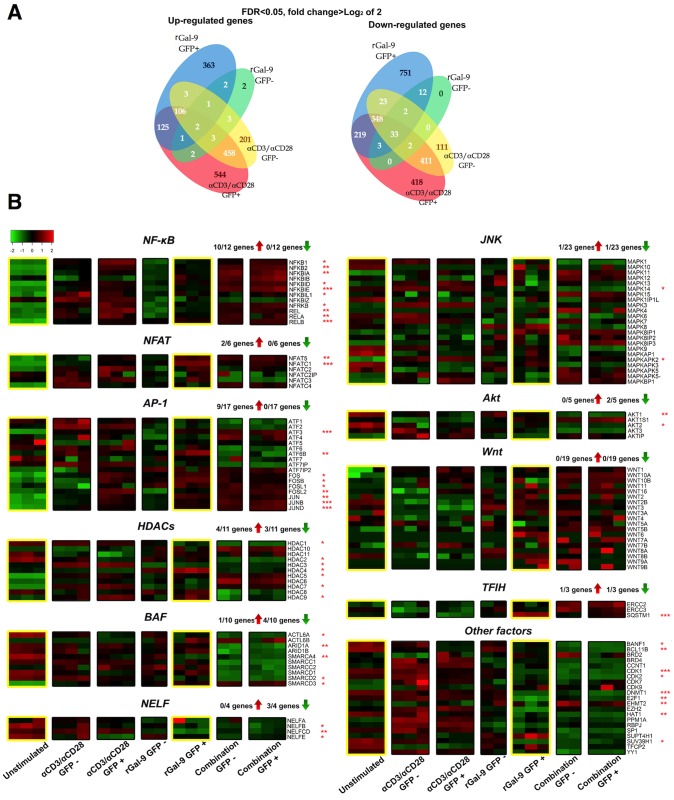
rGal-9 modulates the expression of genes involved in several signaling pathways associated with HIV latency.(A) Venn diagram showing the number of genes modulated by >2 fold with FDR<0.05 in sorted GFP-positive and GFP-negative cells containing reactivated (transcriptionally active) HIV proviruses, and latent (transcriptionally inactive) proviruses, respectively, after either rGal-9 treatment or αCD3/αCD28 stimulation. (B) Heat maps describing effects of rGal-9 treatment on host gene expression, organized by signaling pathways. All statistical comparisons were performed using t tests, and p values were adjusted for multiple comparisons using false discovery rate. Asterisks indicate >2-fold, statistically significant differences in gene expression between r-Gal9-treated, GFP+ cells and unstimulated control, as follows: * = FDR<0.05; ** = FDR<0.01, and *** = FDR<0.001.